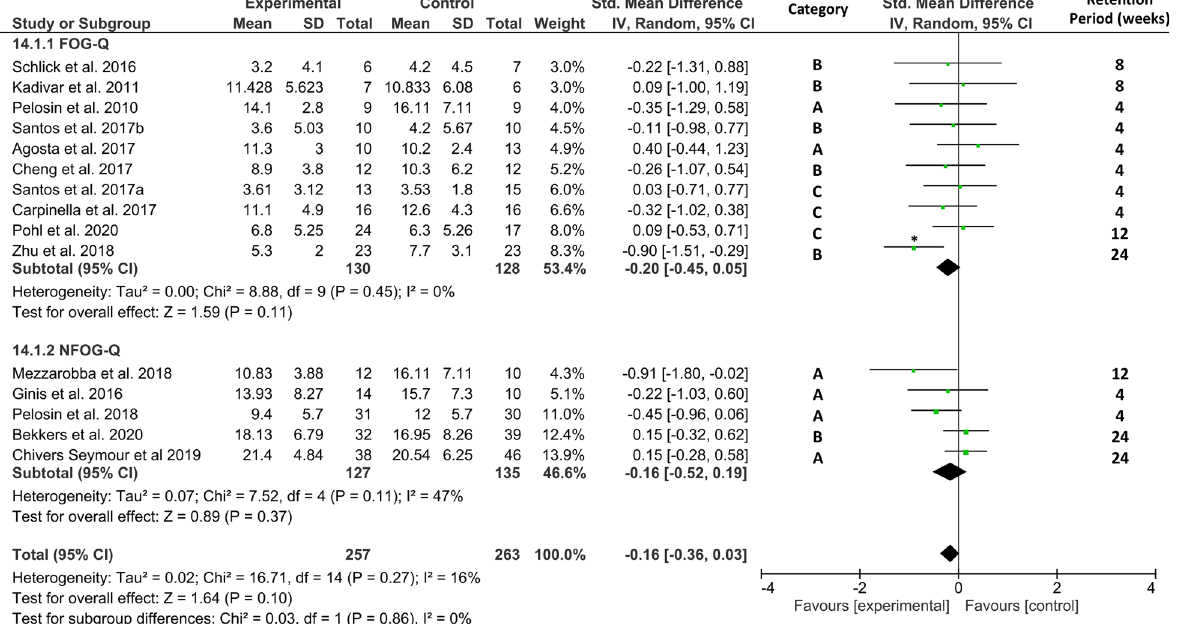
Fig. 10 Secondary analysis comparing retention effects of all types of training/exercise interventions against any type of control group. The studies are arranged per weight of the study as based on sample size; *signi fi cant outliers removed in the sensitivity